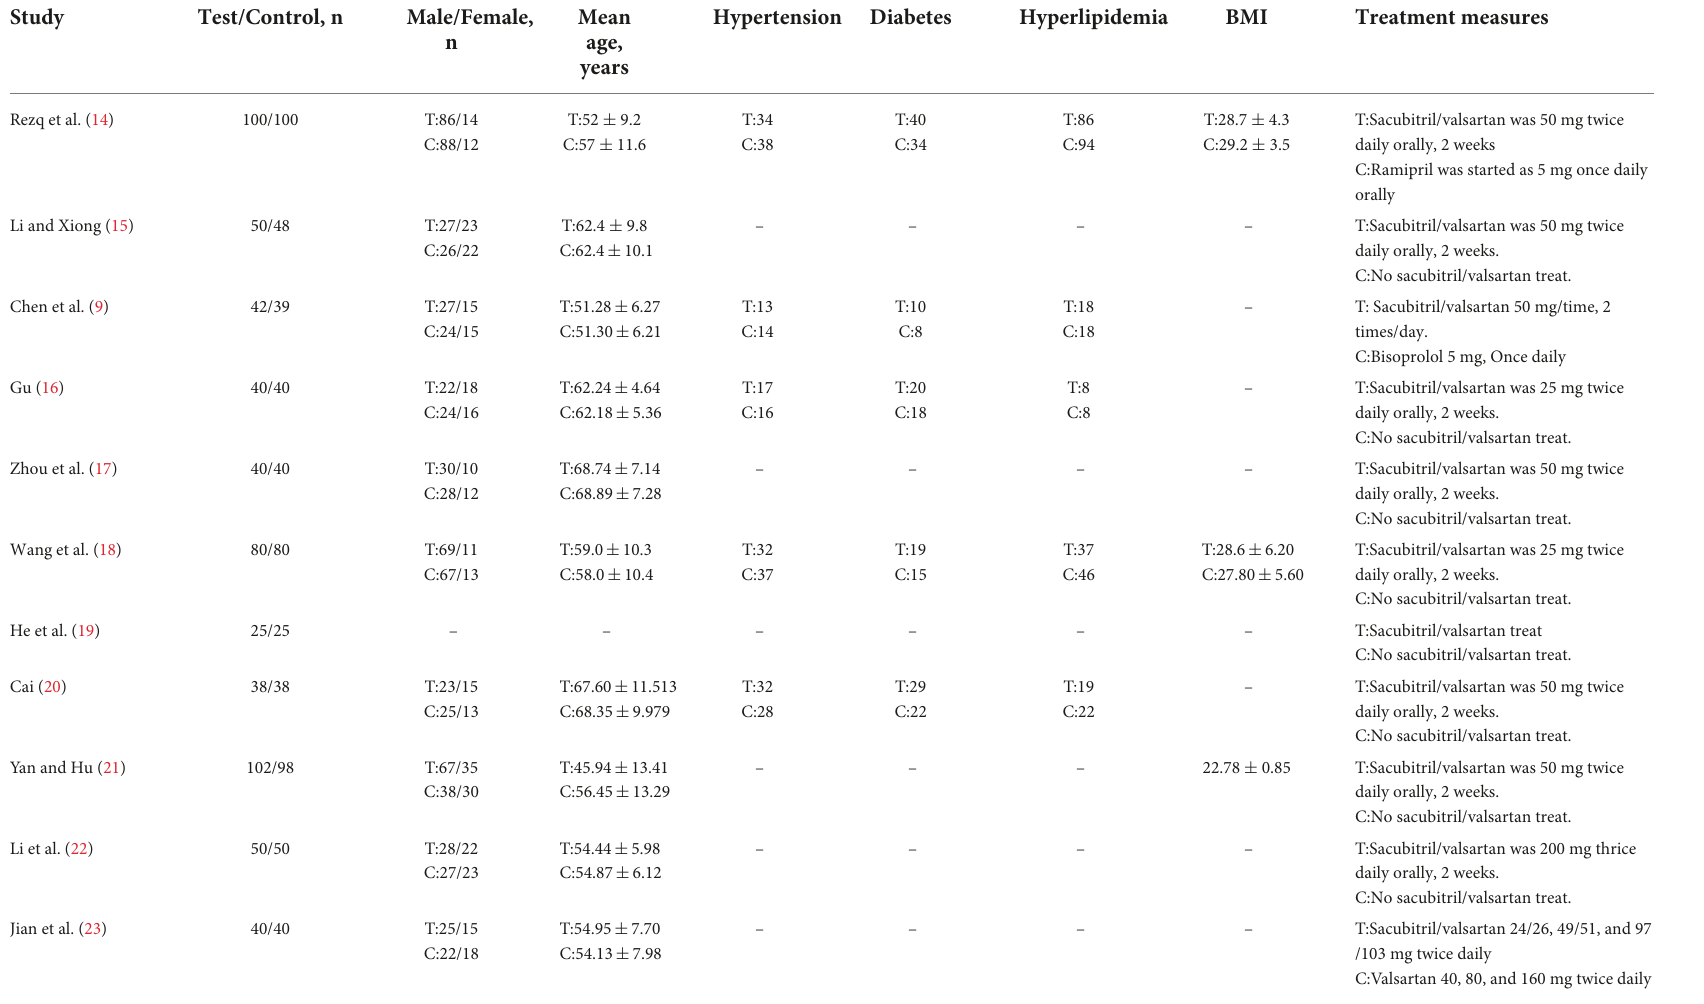
TABLE 1 Characteristics of the included